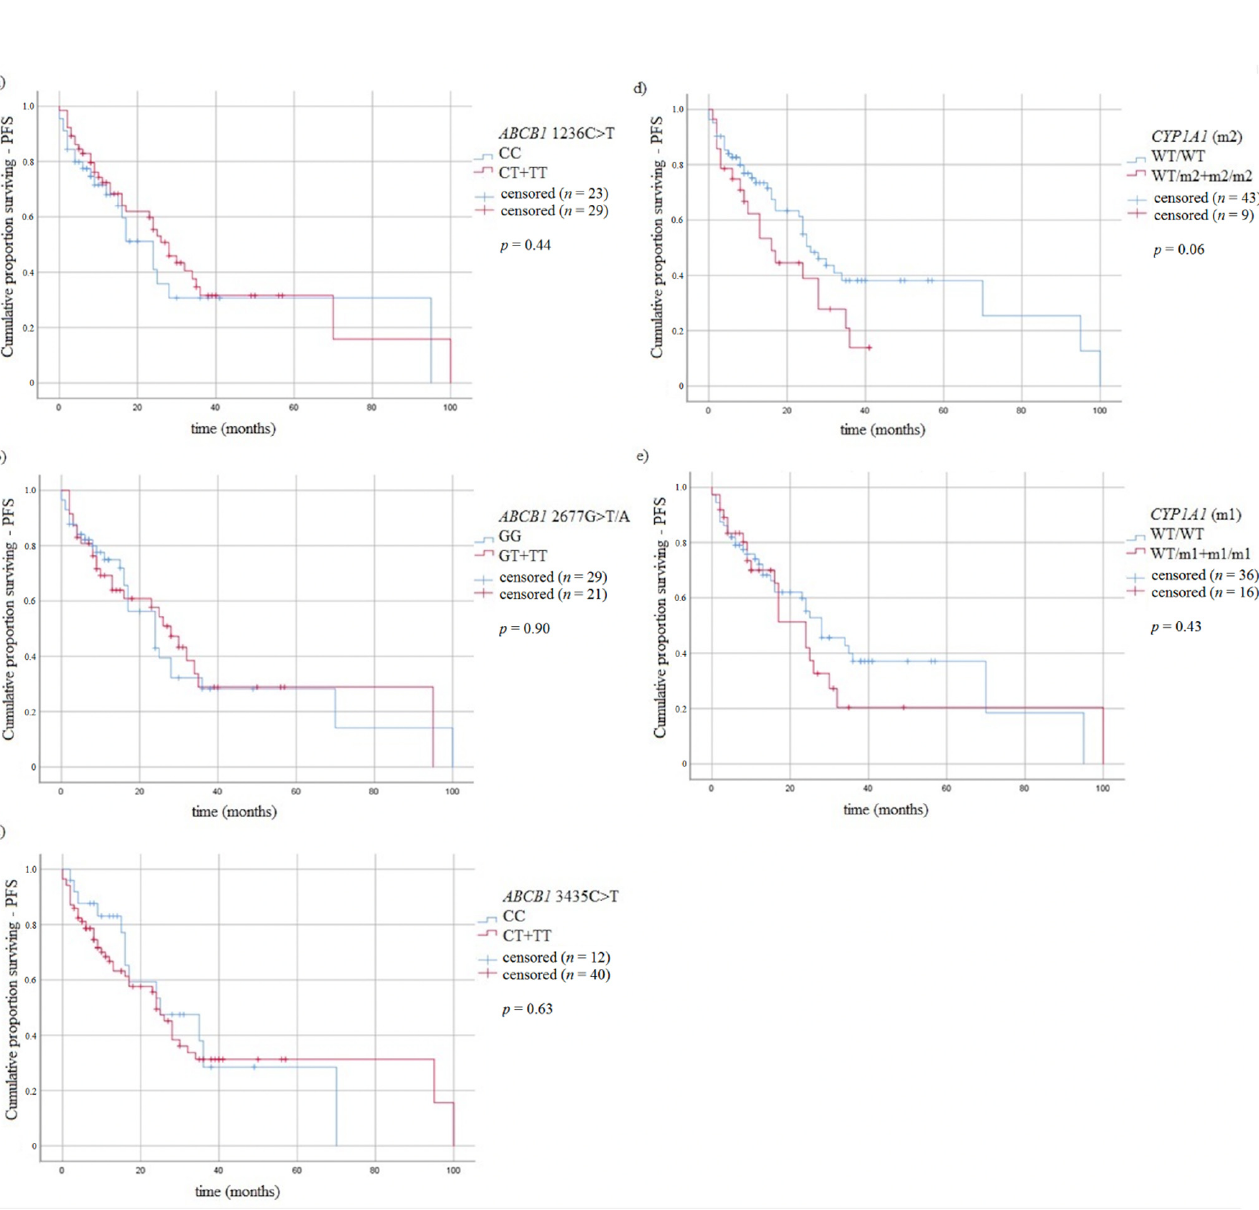
Figure 4. Kaplan ‐ Meier analysis of PFS in MM patients with ( a ) ABCB1 1236C > T genotypes, log ‐ rank test p = 0.44; ( b ) Figure 4. Kaplan-Meier analysis of PFS in MM patients with ( a ) ABCB1 1236C > T genotypes, log-rank test p = 0.44; ABCB1 2677G > T/A genotypes, log ‐ rank test p = 0.90; ( c ) ABCB1 3435C > T, log ‐ rank test p = 0.63; ( d ) CYP1A1 4889A > G ( b ) ABCB1 2677G > T/A genotypes, log-rank test p = 0.90; ( c ) ABCB1 3435C > T, log-rank test p = 0.63; ( d ) CYP1A1 4889A > G genotypes log ‐ rank test p = 0.06; ( e ) CYP1A1 6235T > C genotypes, log ‐ rank test p = 0.43. genotypes log-rank test p = 0.06; ( e ) CYP1A1 6235T > C genotypes, log-rank test p =